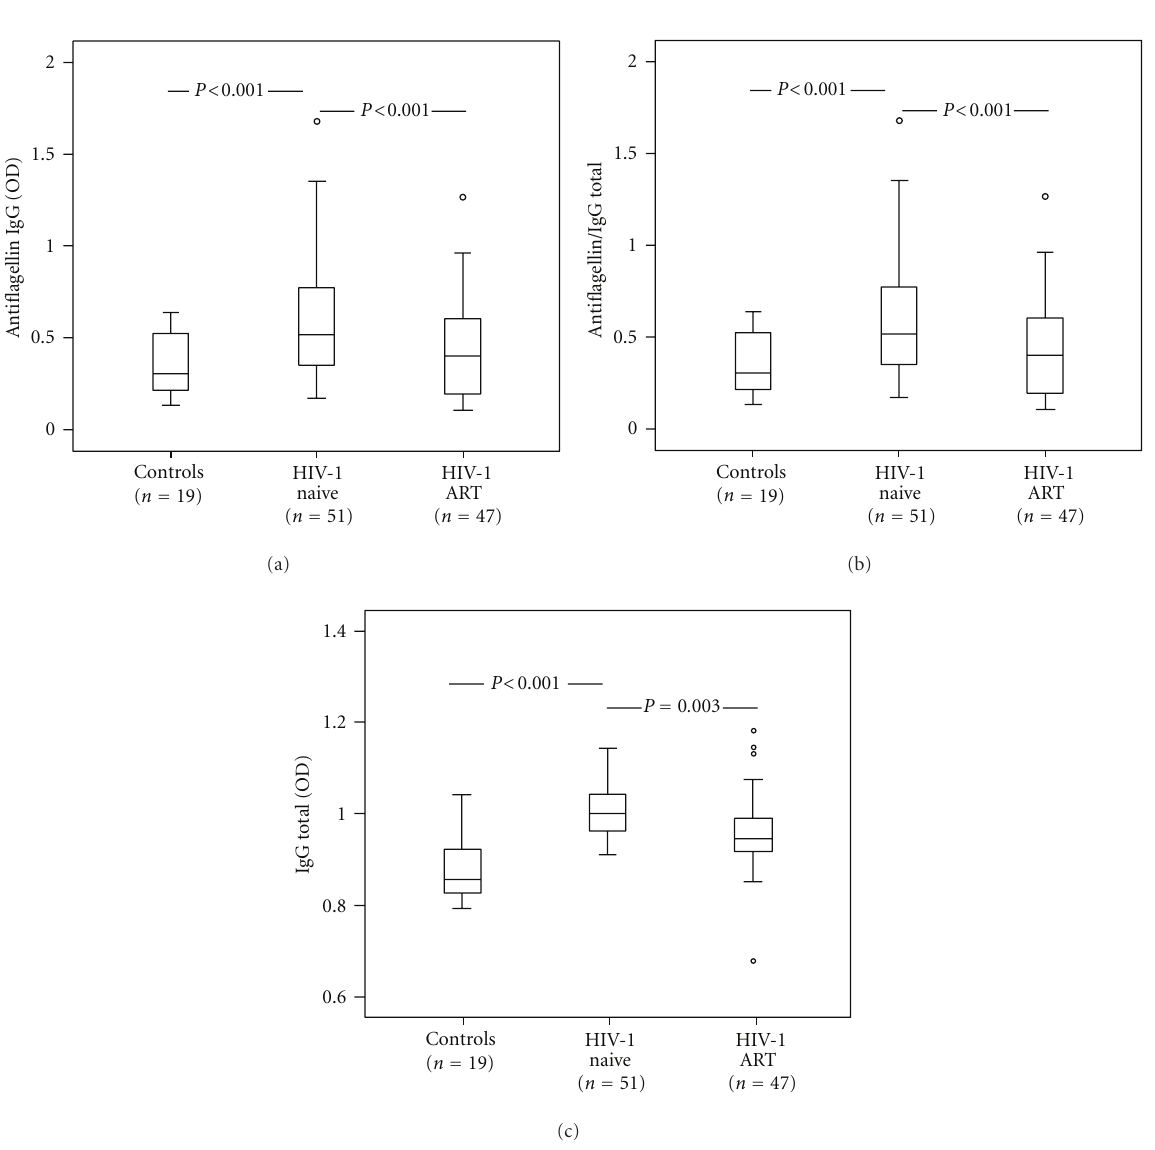
Figure 5: Elevated levels of anti-flagellin IgG are reduced during ART. Plasma levels (OD) of anti-flagellin IgG (a), ratio anti-flagellin IgG/total IgG (b), and total IgG (c) in healthy controls, HIV-1-infected individuals before ( = na¨ıve) and after two years of ART (antiretroviral therapy). The plasma samples were diluted 1:1000. The data are presented as median 25–75 interquartile range and total range. P values refer to intergroup di ff